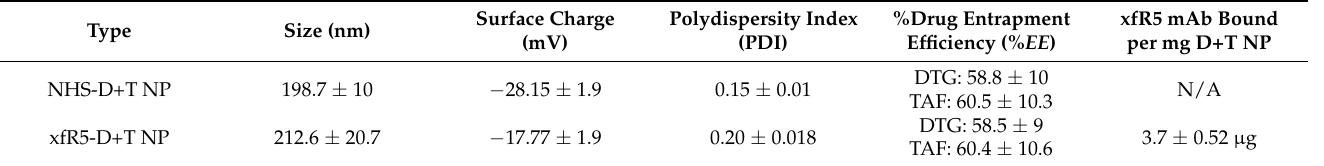
Table 2. Physicochemical characteristics of xfR5-D+T